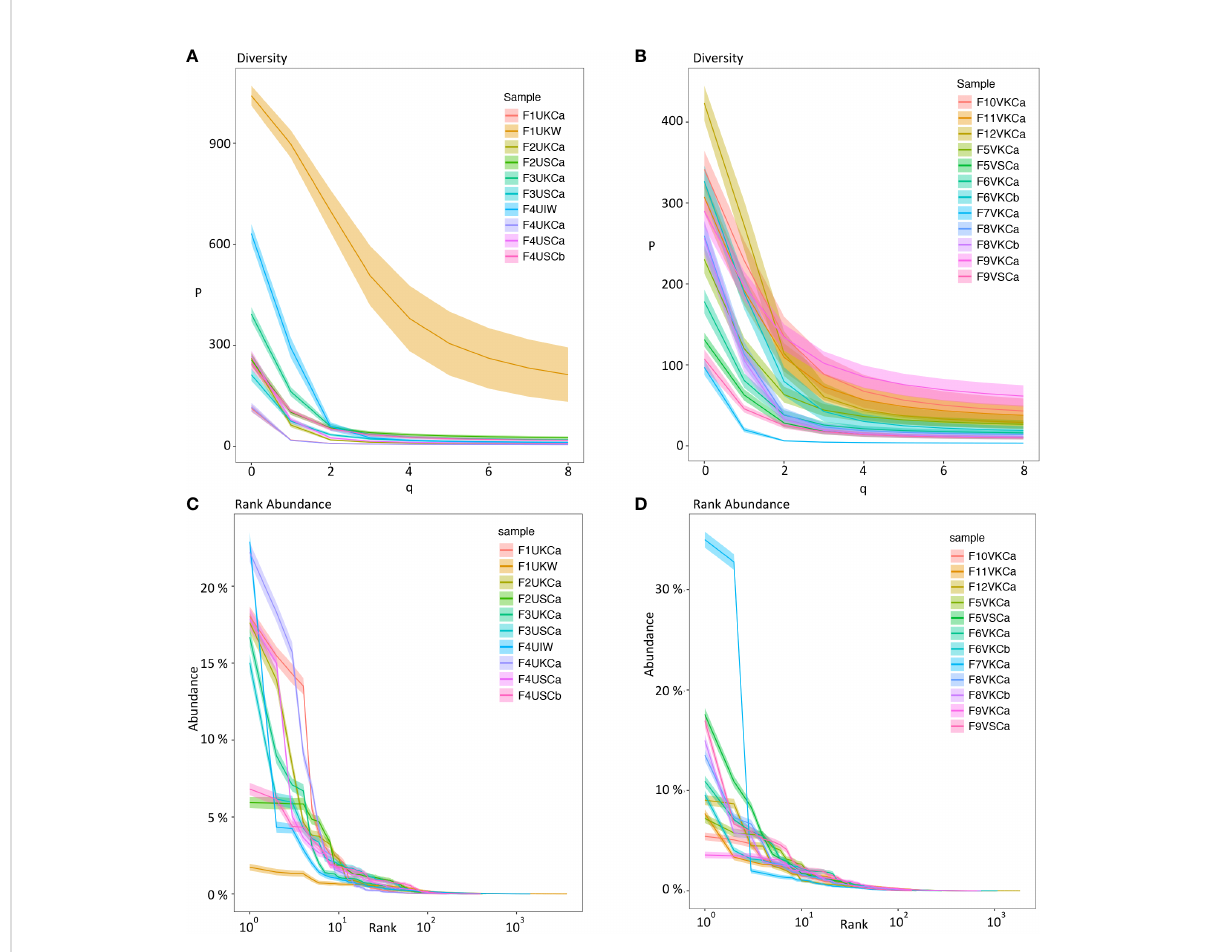
FIGURE 2 Diversity index ( q D ) (Hill numbers) (A, B) and clonal (rank) abundance curves (C, D) using Ig sequences from MM F Cs and whole kidney and intestine. (A, C) MM F Cs from unvaccinated zebra fi sh and the whole kidney and intestine. (B, D) MM F Cs from vaccinated zebra fi sh. q D is the diversity number, q values are the order of the diversity number. q = 0 is the total number of species in a sample, q = 1 is the exponential of Shannon ’ s entropy index (considers species in proportion to their frequency), and q = 2 is the inverse of Simpson ’ s concentration index (considers species in proportion to their frequency and ignores rare species). q= ∞ is the reciprocal of the proportional richness of the commonest species. Rank abundance is the Ig clone size as a percent of the repertoire. The shaded areas are 95% con fi dence intervals. The analysis was performed using Alakazam. Sample designations are ( fi sh number, vaccination status, & tissue source): F# - Fish #; U/V - Unvaccinated/Vaccinated; cluster from K/S - Kidney/Spleen and cluster # - a/b; or W -whole tissue; I -